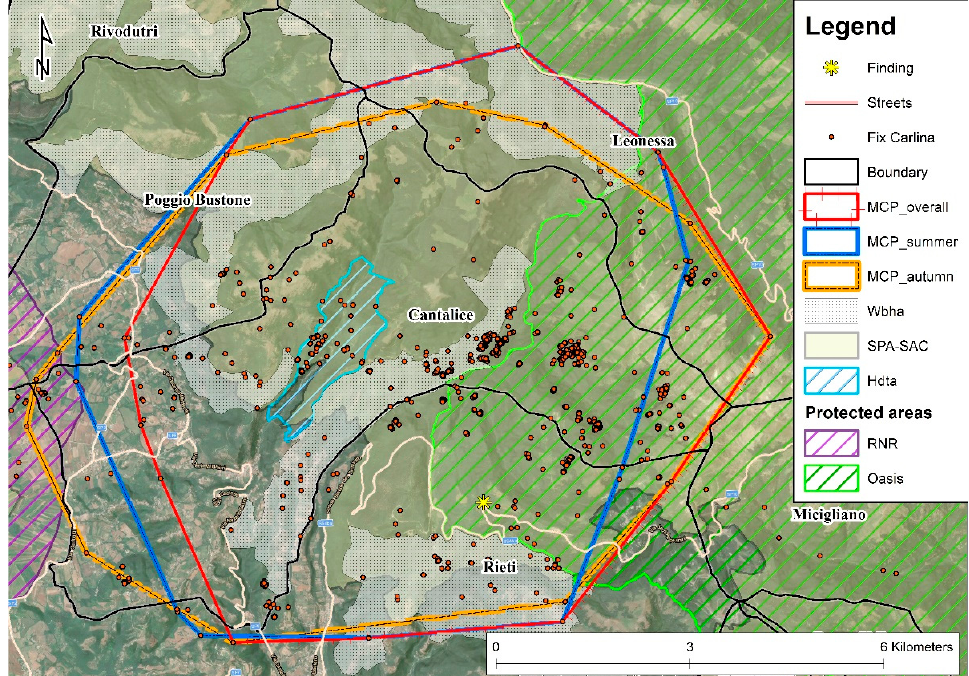
Figure 5. Study area, location of finding and releasing, overall and seasonal minimum convex polygons (95%) and Carlina wolf locations. MCP_summer = during the summer the wild boar drive hunting is banned; MCP_autumn = during the autumn this hunting is in progress. Wbha = wild boar drive hunting areas; Htda = hunting dog training areas; Oasis = Terminillo wildlife oasis; RNR = regional natural reserve “Laghi Lungo e Ripasottile”.